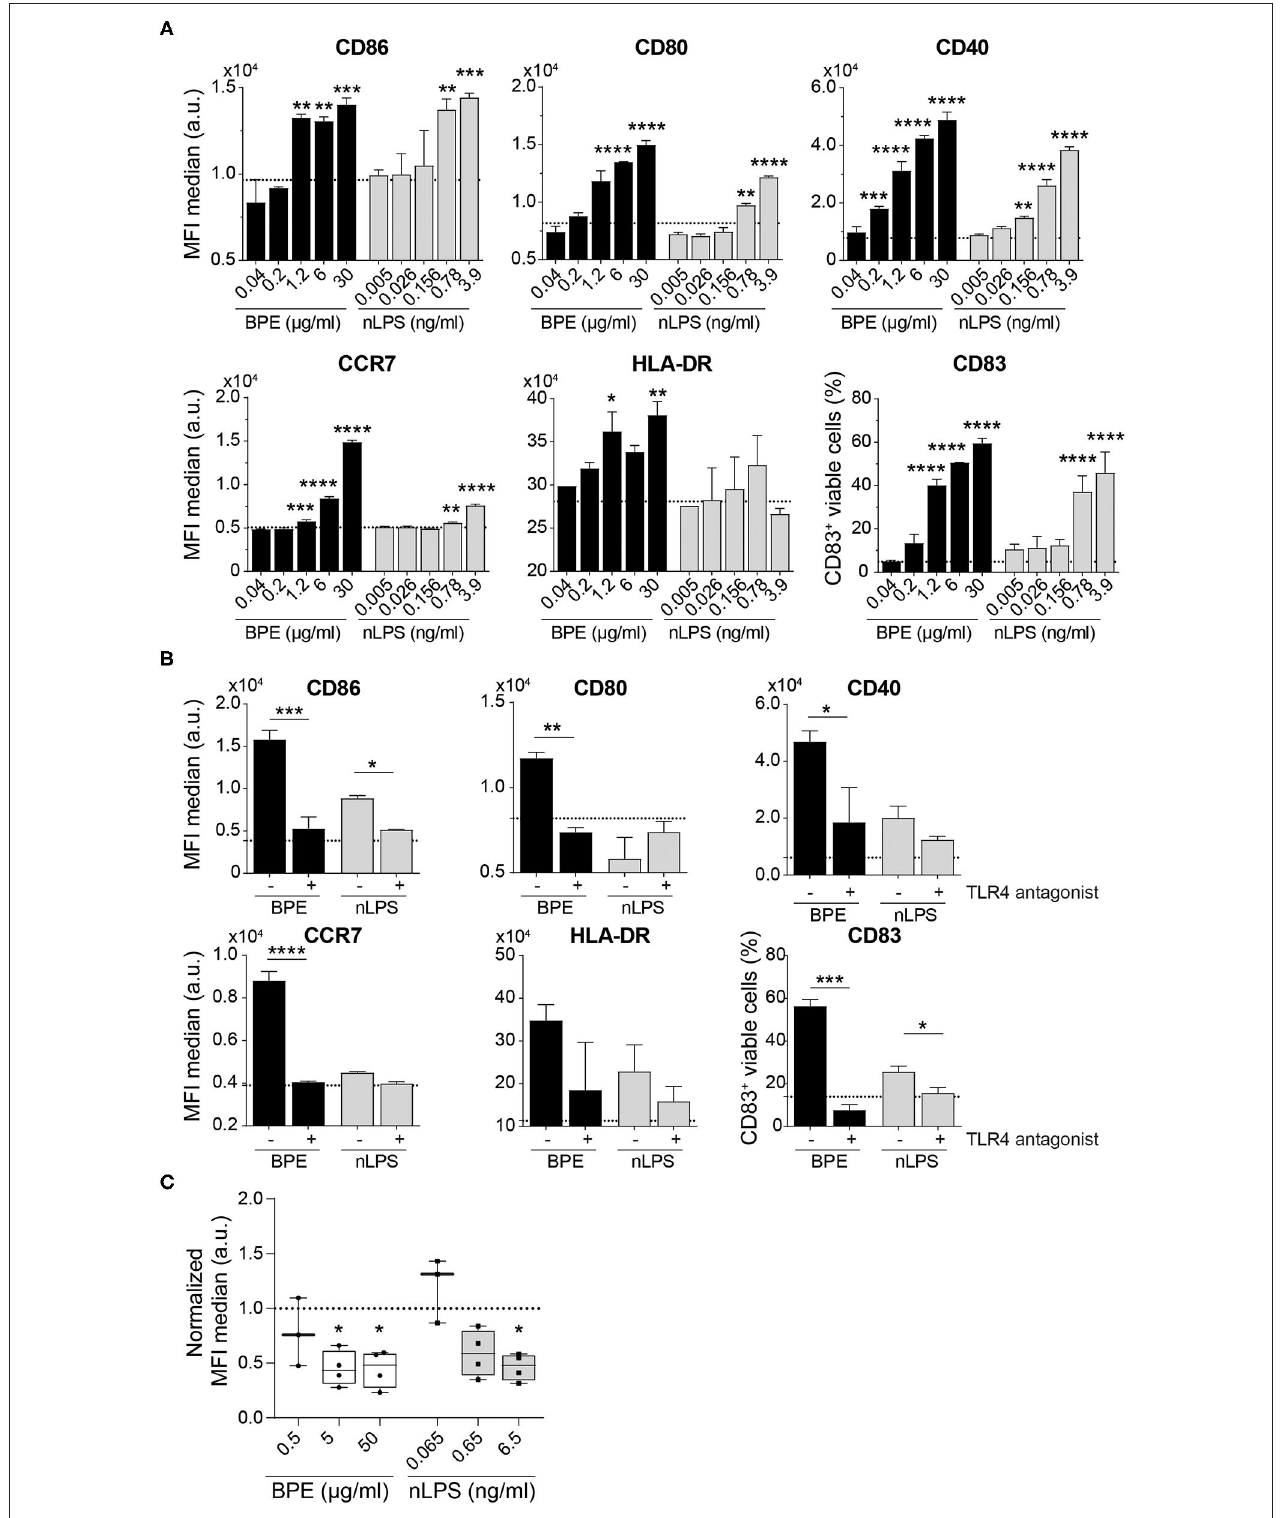
FIGURE 5 | BPE-induced activation of human moDCs is abolished using a TLR4 antagonist. Surface expression of six distinct maturation markers on human moDCs was analyzed upon treatment with serial dilutions of BPE or the related nLPS concentration (A) . Regulation of the maturation markers in human moDCs stimulated